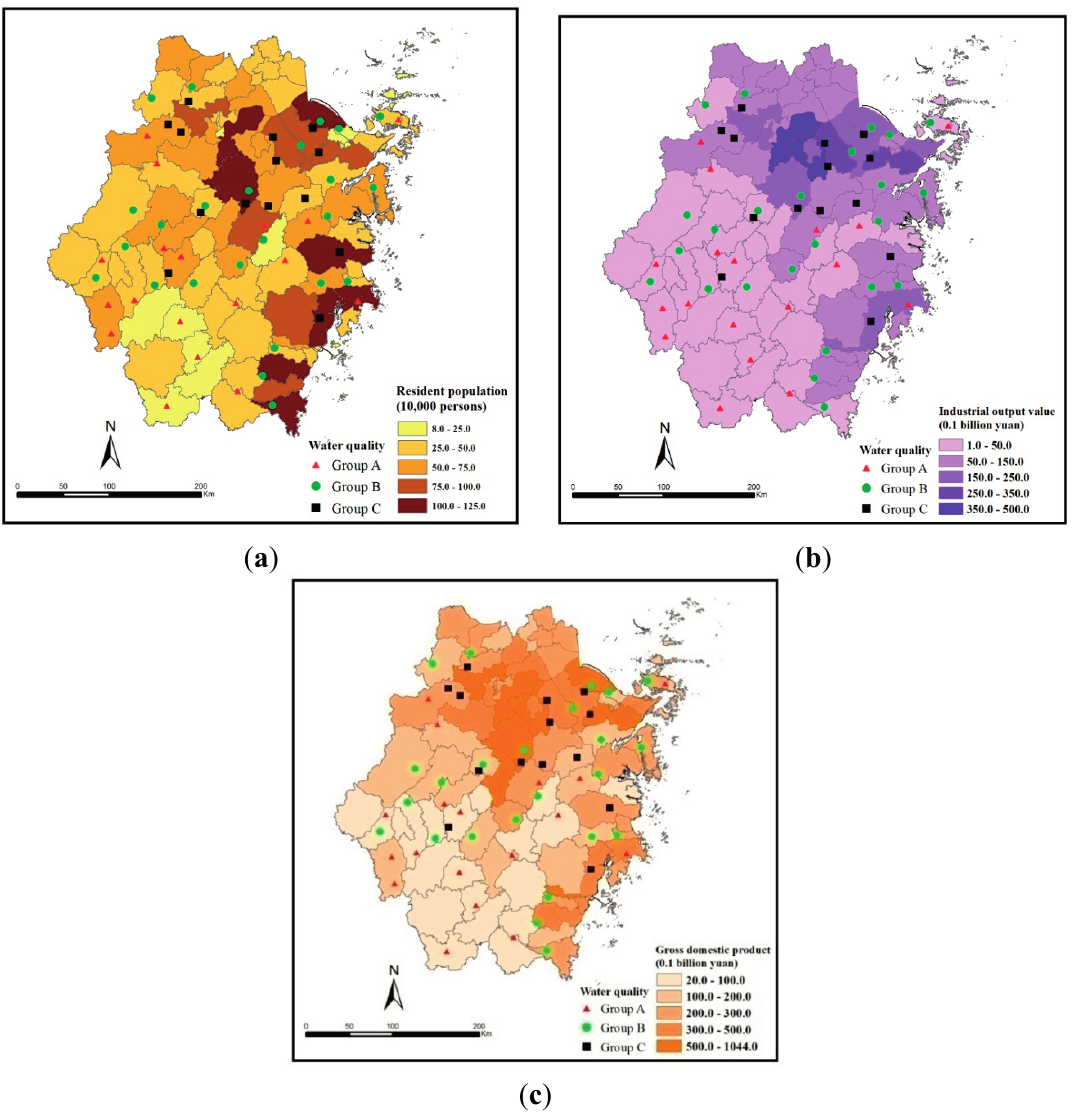
Figure 4. Spatial distributions of the selected socio-economic indicators at the county level of Zhejiang Province in 2010: ( a ) resident population; ( b ) gross industrial output value; ( c )